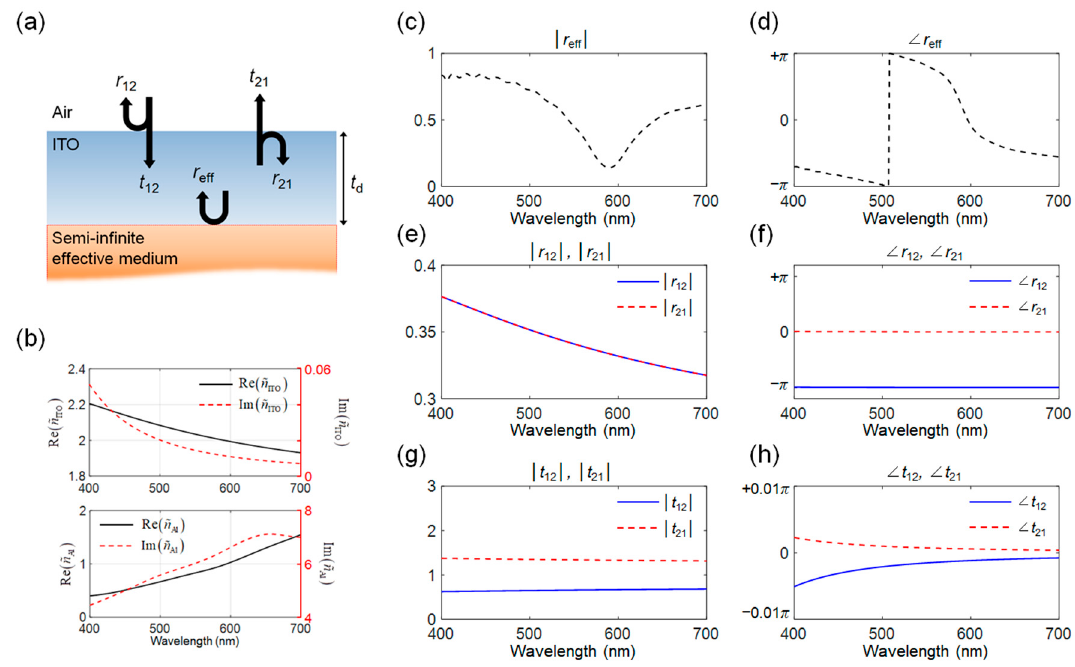
Figure 3. ( a ) Diagram showing the reflection and transmission coefficients for calculation of the optical response of the metallic grating coated with a lossy dielectric using the numerical effective medium approach. ( b ) Experimentally measured optical constants of ITO and Al. ( c ) Magnitude and ( d ) phase profiles of the reflection coefficient at the interface between ITO and effective medium. ( e ) Magnitude and ( f ) phase profiles of the Fresnel reflection coefficients, and ( g ) magnitude and ( h ) phase profiles of the Fresnel transmission coefficients at the interface between air and ITO. All coefficients are calculated for normally incident light at visible frequencies.